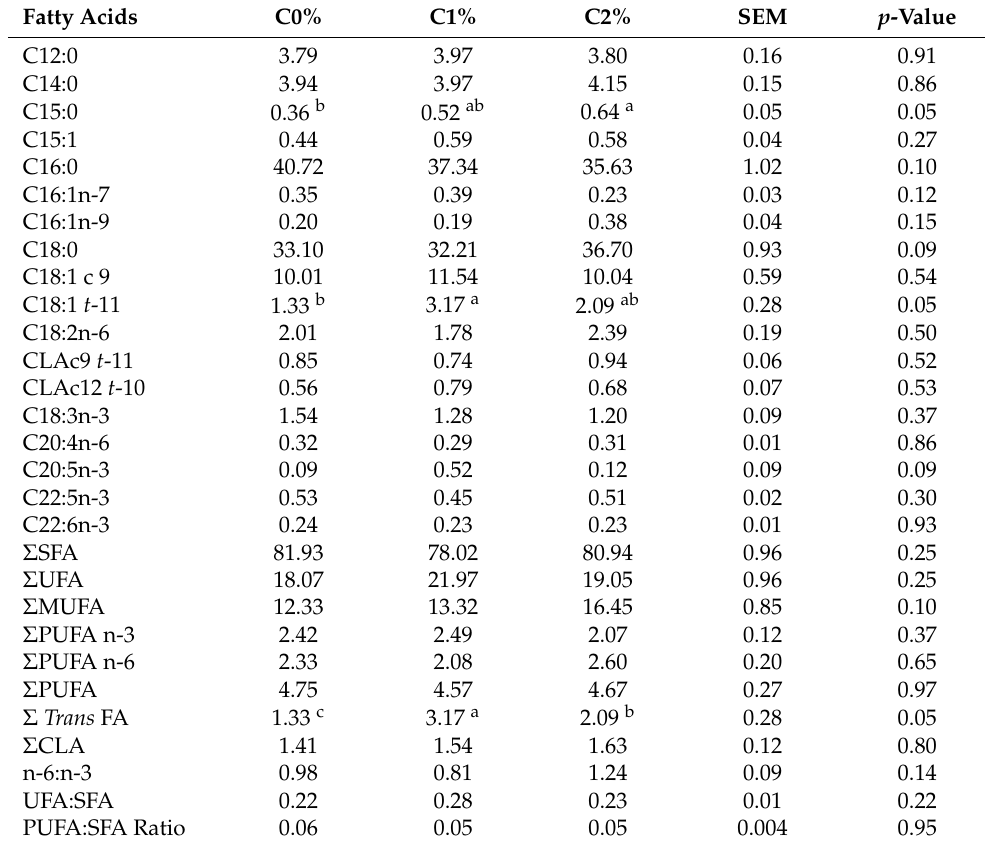
Table 7. Fatty acid composition (g/100 g total fatty acids) of rumen fluid in vivo fermentation of different levels of corn substitution.